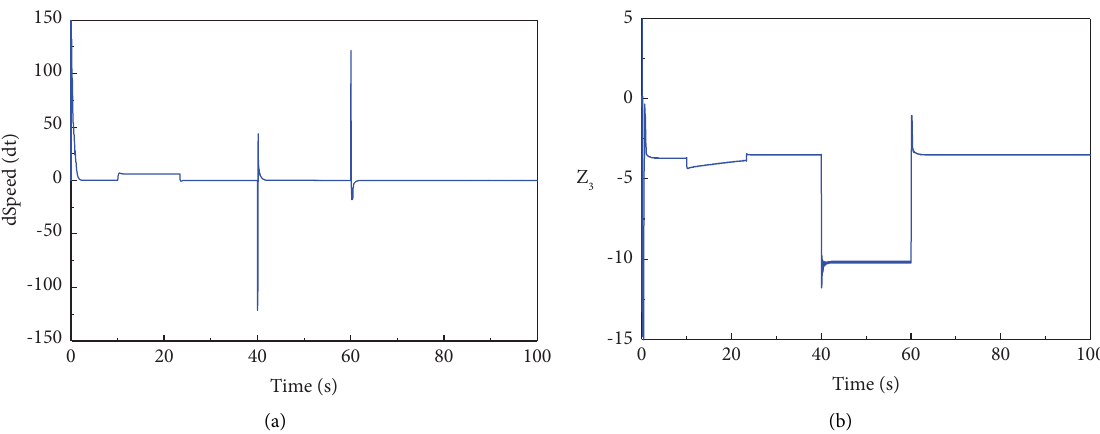
Figure 16: Speed diferential signal and engine status parameter Z